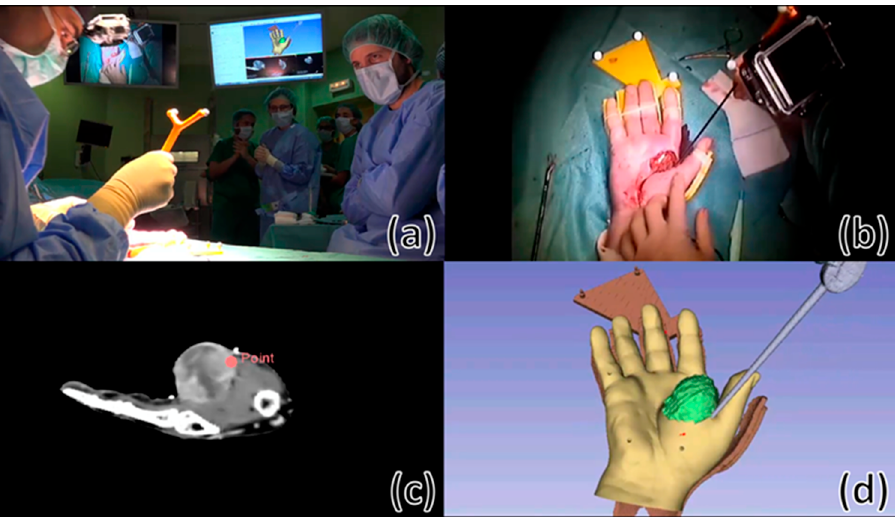
Figure 7. Image-guided surgery (IGS) during acral tumor resection surgery of case 1: ( a ) surgeons in the operating room (OR); ( b ) case 1 affected limb after tumor resection; ( c ) CT image; ( d ) AcralTumorNavigation software visualization of virtual 3D models. The red point in the CT image depicts the pointer tip. The green 3D model represents the tumor. All images are synchronized at the same moment of the surgery (Video S1).